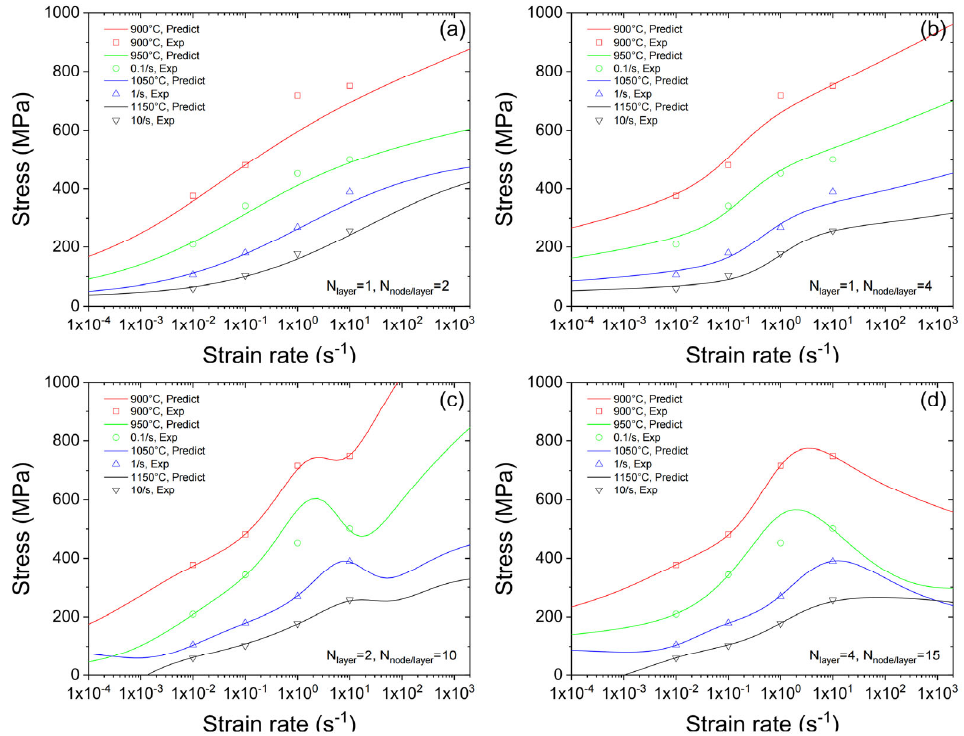
Figure 7. Predicted strain rate dependency of flow stress using ANNs with different structures. ( a – d ) are the predicted stress-strain rate curves demonstration of ANNs with 1 × 2, 1 × 4, 2 × 10, 4 × 15 sizes.